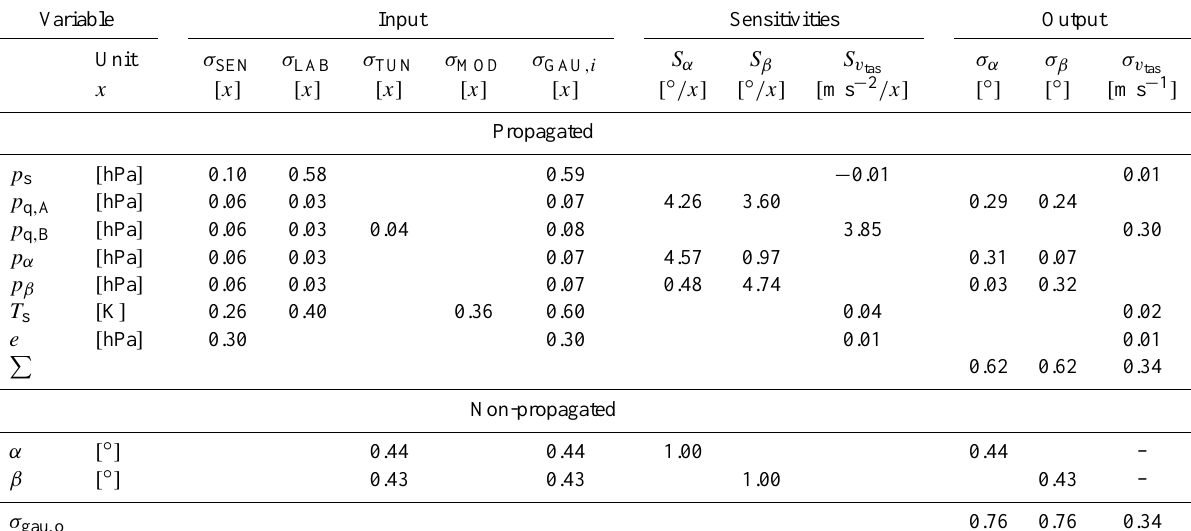
Table 5. Uncertainty of variables entering the wind vector computation Eq. (A1): Static pressure ( p s ), dynamic pressure as used in the computation of flow angles ( p q , A ) and the true airspeed ( p q , B ), differential pressures ( p α , p β ), static temperature ( T s ) and water vapour pressure ( e ). Sources of uncertainty ( σ ) are subscripted as follows: manufacturer provided sensor uncertainty (SEN), calibration in laboratory (LAB), wind tunnel (TUN), and wind model description (MOD). The 0.05K and 0.36K uncertainties for radiation and ram rise errors in T s were accounted in σ mod . Additional information is given in Sect.